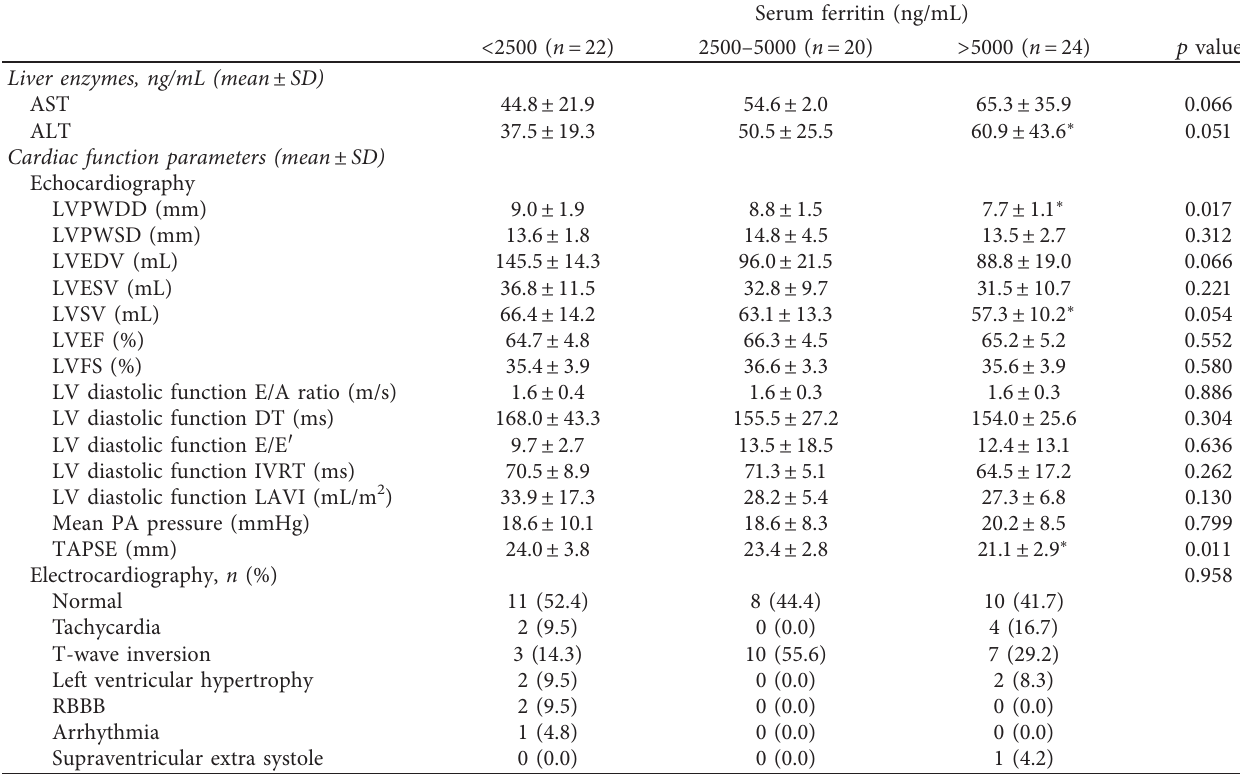
Table 2: Liver enzyme and cardiac function parameters stratified by serum ferritin level